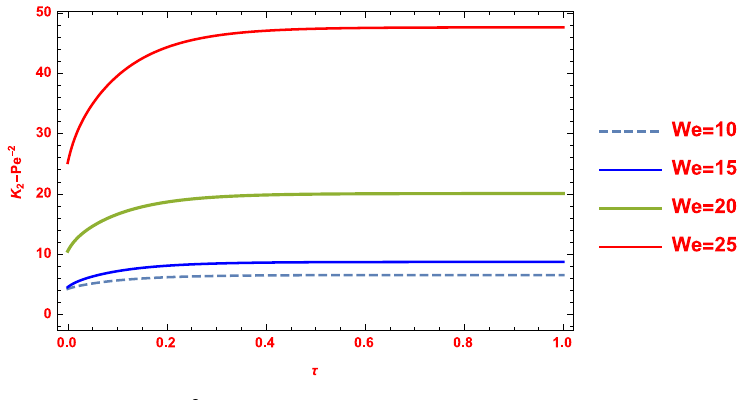
Figure 3. K 2 − Pe − 2 varying along τ for different We .